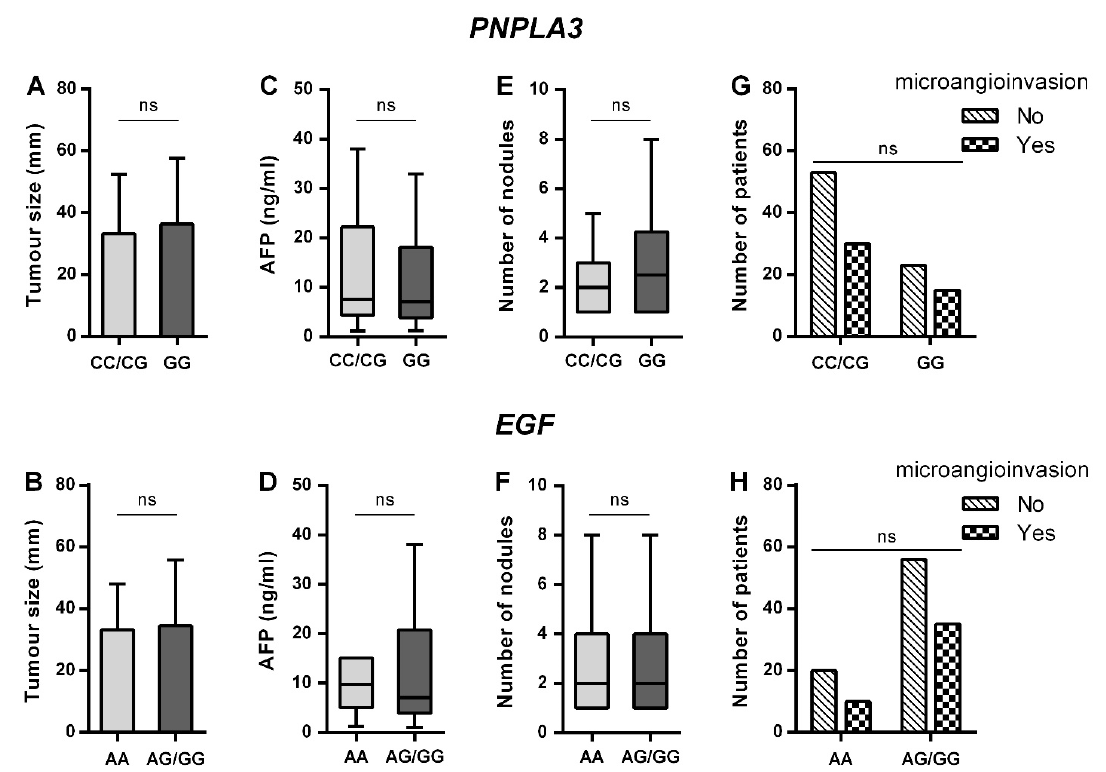
Figure 2. Association of SNPs with HCC-related parameters. Tumor size ( A , B ), alpha-fetoprotein levels ( C , D ), and number of nodules ( E , F ) are presented as median with interquartile range; the Mann–Whitney-U test was used for statistical comparison. For microangioinvasion ( G , H ), the number of patients is shown, and the chi-square test was used for statistical comparison. AFP—alpha-fetoprotein; EGF —epidermal growth factor; ns—not significant; PNPLA3 —patatin-like phospholipase domain-containing protein